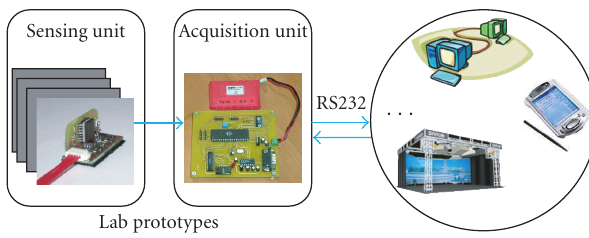
Figure 1: The gesture recognition interface can interact with vari- ous hardware